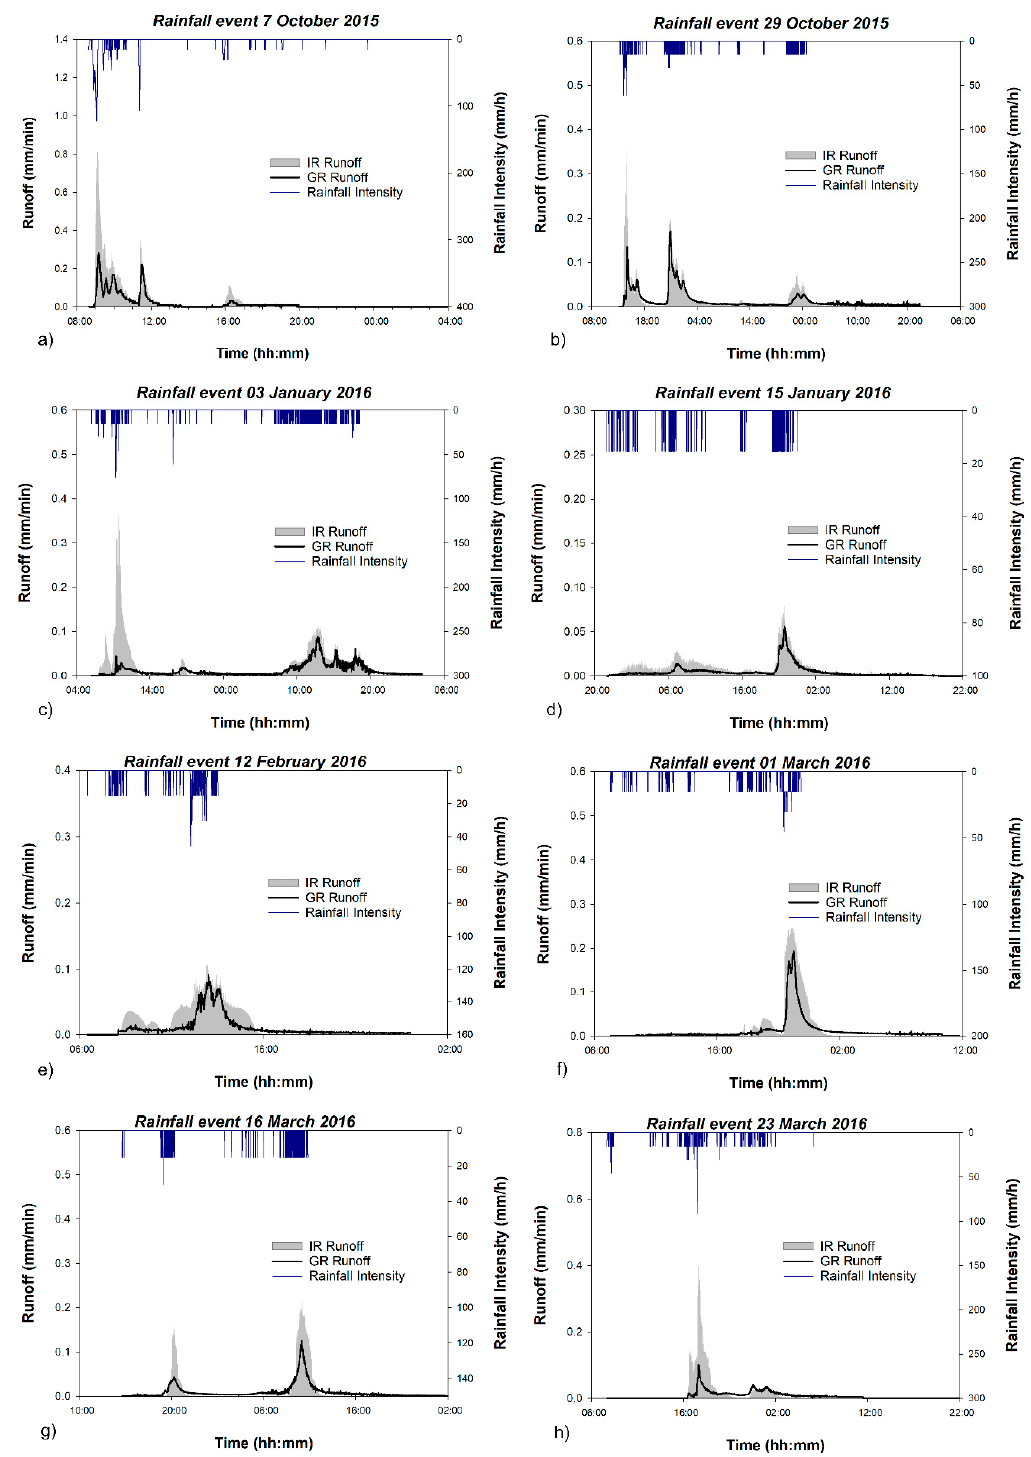
Figure 3. Hyetographs and corresponding green roof (GR) and impervious roof (IR) runo ff hydrographs for eight selected rainfall events: ( a ) 7 October 2015 (total precipitation depth (PD) = 42.2 mm and total green roof runo ff depth (GR-RD) = 20.0 mm); ( b ) 29 October 2015 (PD = 63.3 mm and GR-RD = 46.4 mm); ( c ) 03 January 2016 (PD = 66.3 mm and GR-RD = 32.7 mm); ( d ) 15 January 2016 (PD = 24.9 mm and GR-RD = 13.2 mm); ( e ) 12 February 2016 (PD = 18.8 mm and GR-RD = 11.1 mm); ( f ) 01 March 2016 (PD = 31.0 mm and GR-RD = 19.9 mm); ( g ) 16 March 2016 (PD = 27.9 mm and GR-RD = 19.4 mm); ( h ) 23 March 2016 (PD = 34.3 mm and GR-RD = 16.1 mm).